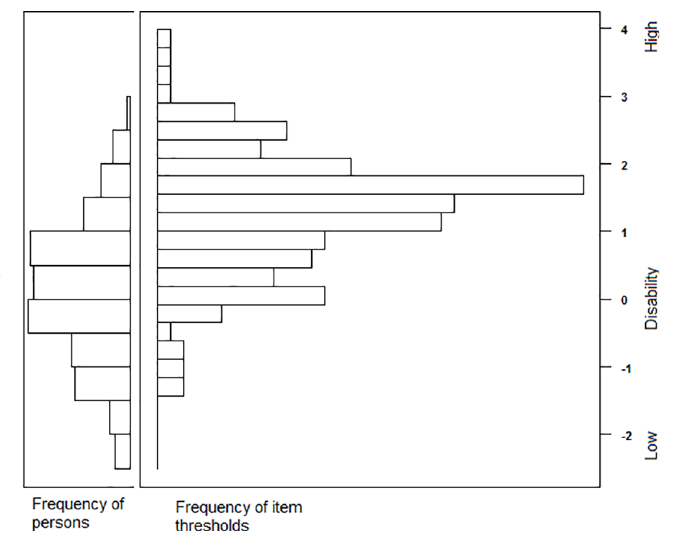
Fig 2. Item-person map of the